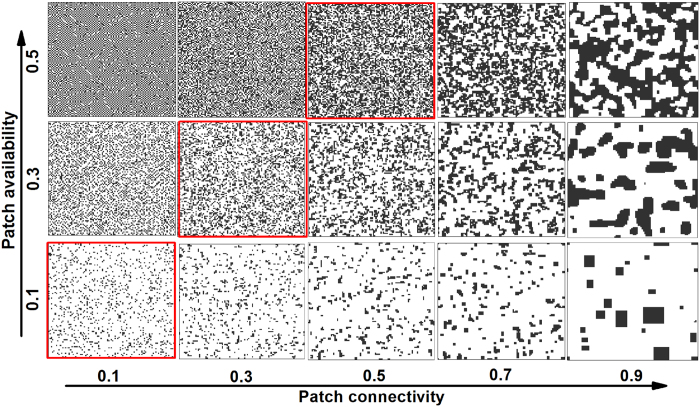
Artificial fragmented landscapes consisting of two patch types (black – suitable, white – unsuitable) in a square lattice of size L × L = 100 × 100 cells with each cell representing one patch, differentiated by varying both patch availability (s) and connectivity (qs/s).Each image shows a typical configuration for the given properties. In the special case with qs/s = s, both patch types are randomly distributed (marked with red square), while the cases of qs/s > s and qs/s < s respectively represent spatially clustered and over-dispersed patterns of suitable patches.